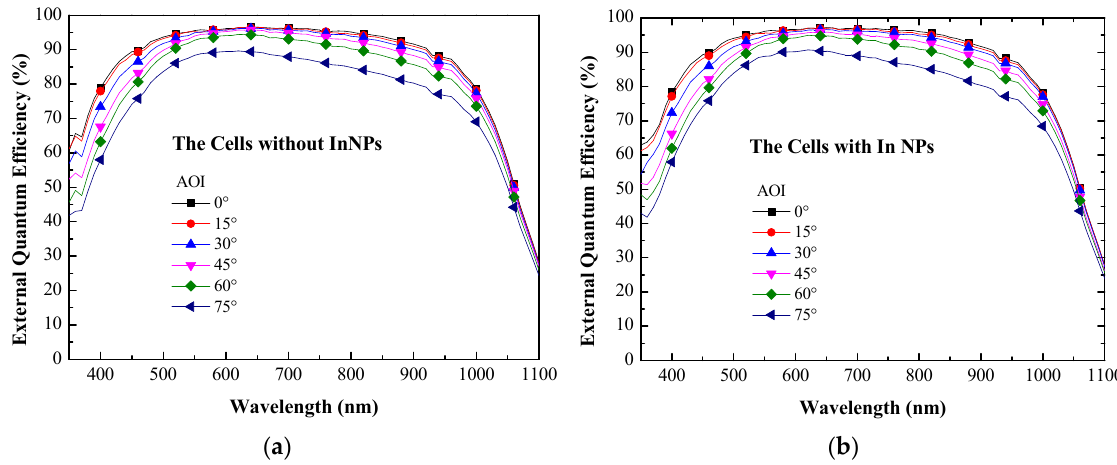
Figure 9. EQE response of ( a ) reference silicon solar cell (textured but without NPs) and ( b ) textured silicon solar cell coated with In NPs, measured at AOI of 0°–75°.